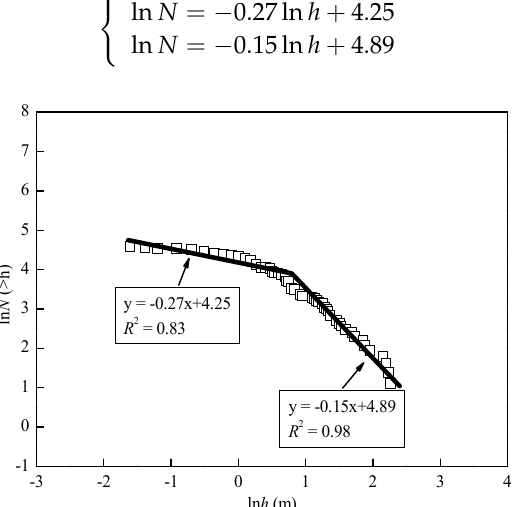
Figure 9. Fractal model describing the relationship between the 98 geological drilling holes and the diameters of the karst caverns.